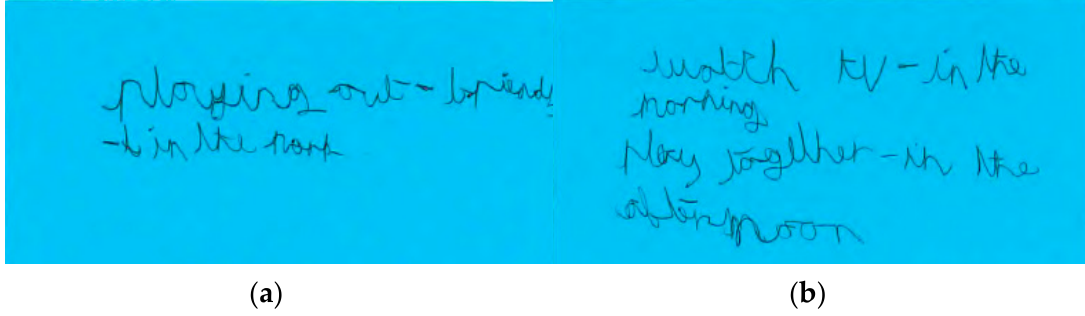
Figure 6. ( a , b ) Show/tell data illustrating Tom Smith’s leisure activities. “Playing out. I’ve been playing out with my friends in the park. My friends from school. We just walk everywhere we go. Straight after school I would either just go to the park with my mates or go to the forest. The one by school or the one by Mackie’s, the rec. And if I don’t do that, then I ʹ ll go home and get ready. Get changed, and then out to the park. I ʹ m allowed like to the rails and back. I’m allowed to stay there til 8 o’clock. I tend to just stay in on weekends” [Tom